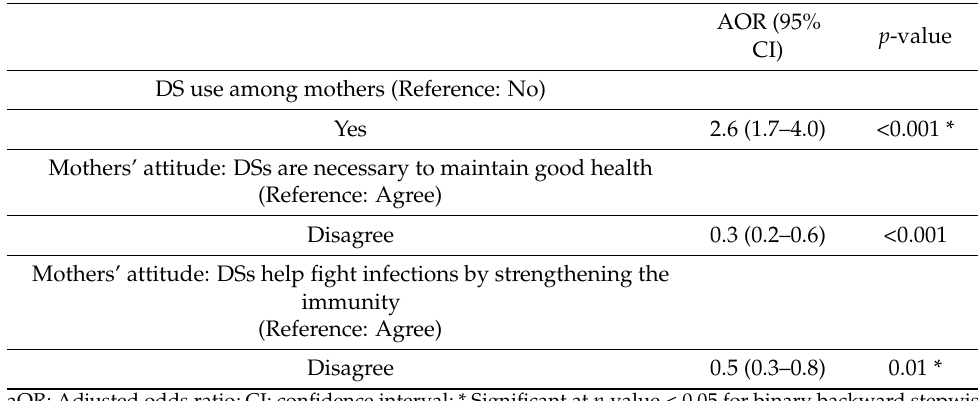
Model 2: Binary backward stepwise regression taking oral dietary supplementation